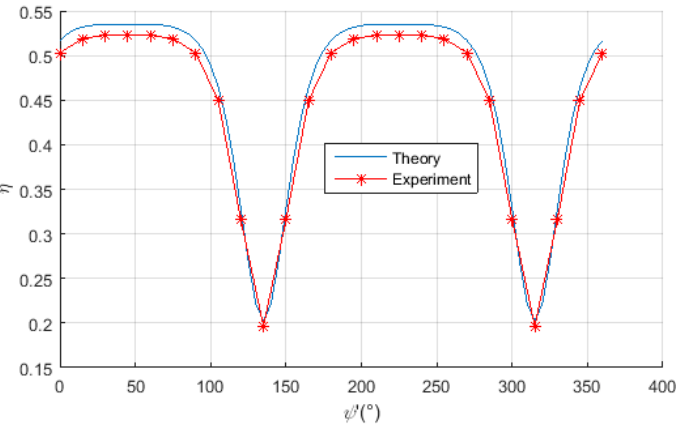
Figure 16. The power transfer efficiency versus the receiving coil rotating along the dotted line at the location (0.28 m, 0.28 m and 0 m).